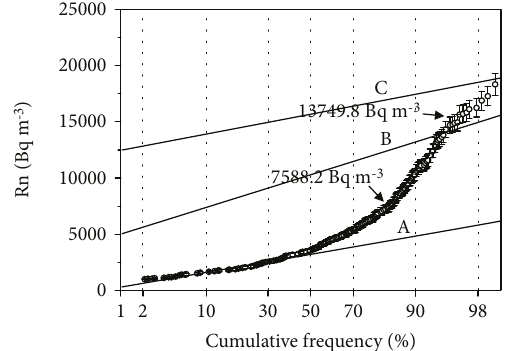
Figure 4: Probability plots of soil gas CO sampling points.